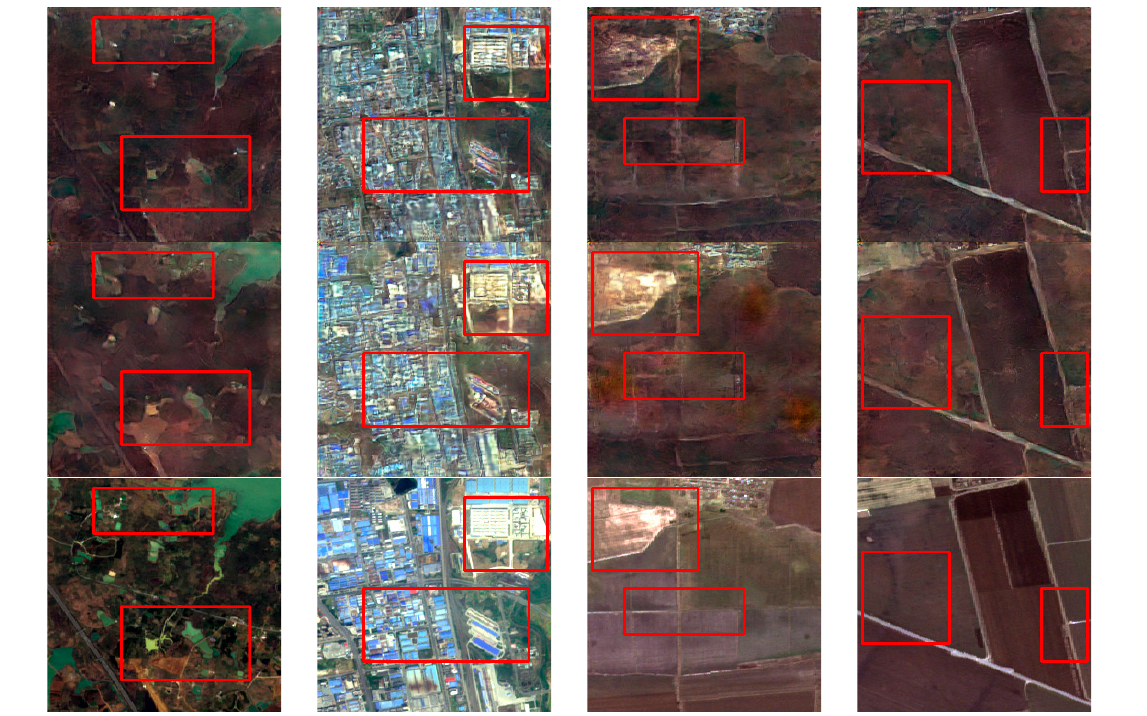
Figure 8. A visual comparison of the results from the ablation experiment. (1) SEN-1 SAR image. (2) Guo [38]. Adapted with permission from Ref. [38]. 2021, Xiefan Guo. (3) Ours (+ MSE Loss). (4) Ours (+ MSE loss + FFL Loss). (5) SEN-2 optical image. Table 3. IQA results in the ablation experiment obtained by averaging the evaluation metrics over 222 pairs of images in the test set. The best values for each evaluation index are shown in bold.